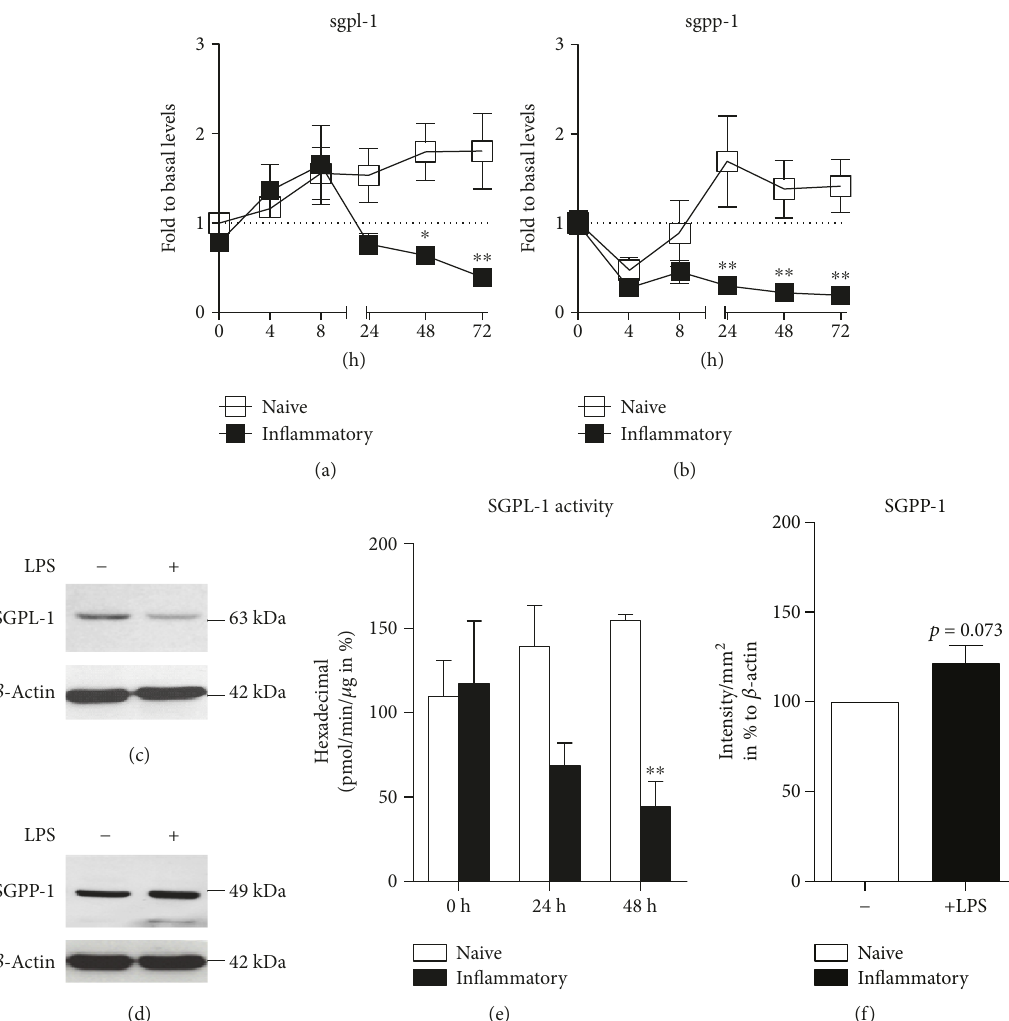
Figure 1: (a, b) Quantitative real-time PCR for sgpl-1 and sgpp-1 mRNA in naive and LPS-stimulated dendritic cells over time ( n = 4 ). (c) Western blot with anti-SGPL-1 antibody and anti- β -actin antibody in naive and LPS-stimulated DCs after 48h. (d) Quanti fi cation of hexadecenal for SGPL-1 activity in naive and LPS-stimulated dendritic cells with QTOF-MS ( n = 3 ). (e) Western blot for anti-SGPP-1 antibody and anti- β -actin antibody in naive and LPS-stimulated DCs after 48 h ( n = 3 ). (f) Quanti fi cation of Western blot bands of (e) (statistical test: one sample t -test). Data represent mean ± SD; ∗ p ≤ 0 05 and ∗∗ p ≤ 0 01